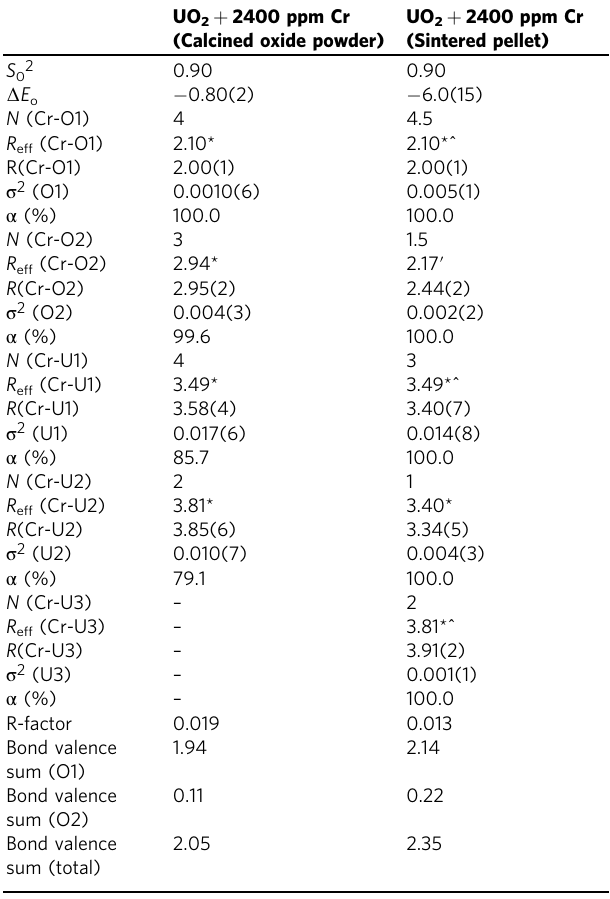
Table 1 Fitting parameters and results for 2400 ppm Cr-doped UO 2 calcined oxide powder and sintered pellet